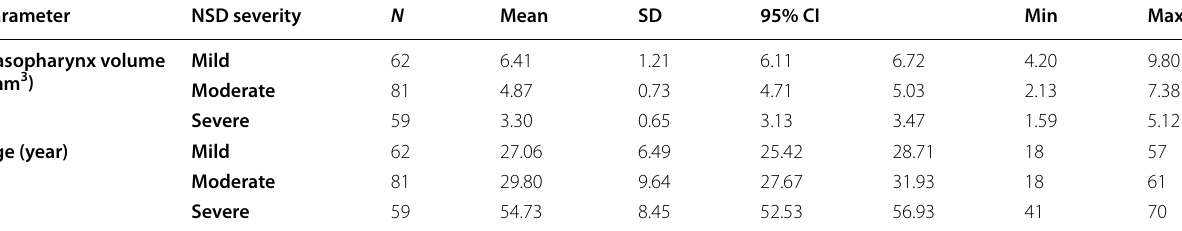
Table 2 Descriptive statistics and 95% CIs for nasopharynx volumes (mm 3 ) and age (year) in different NSD severities